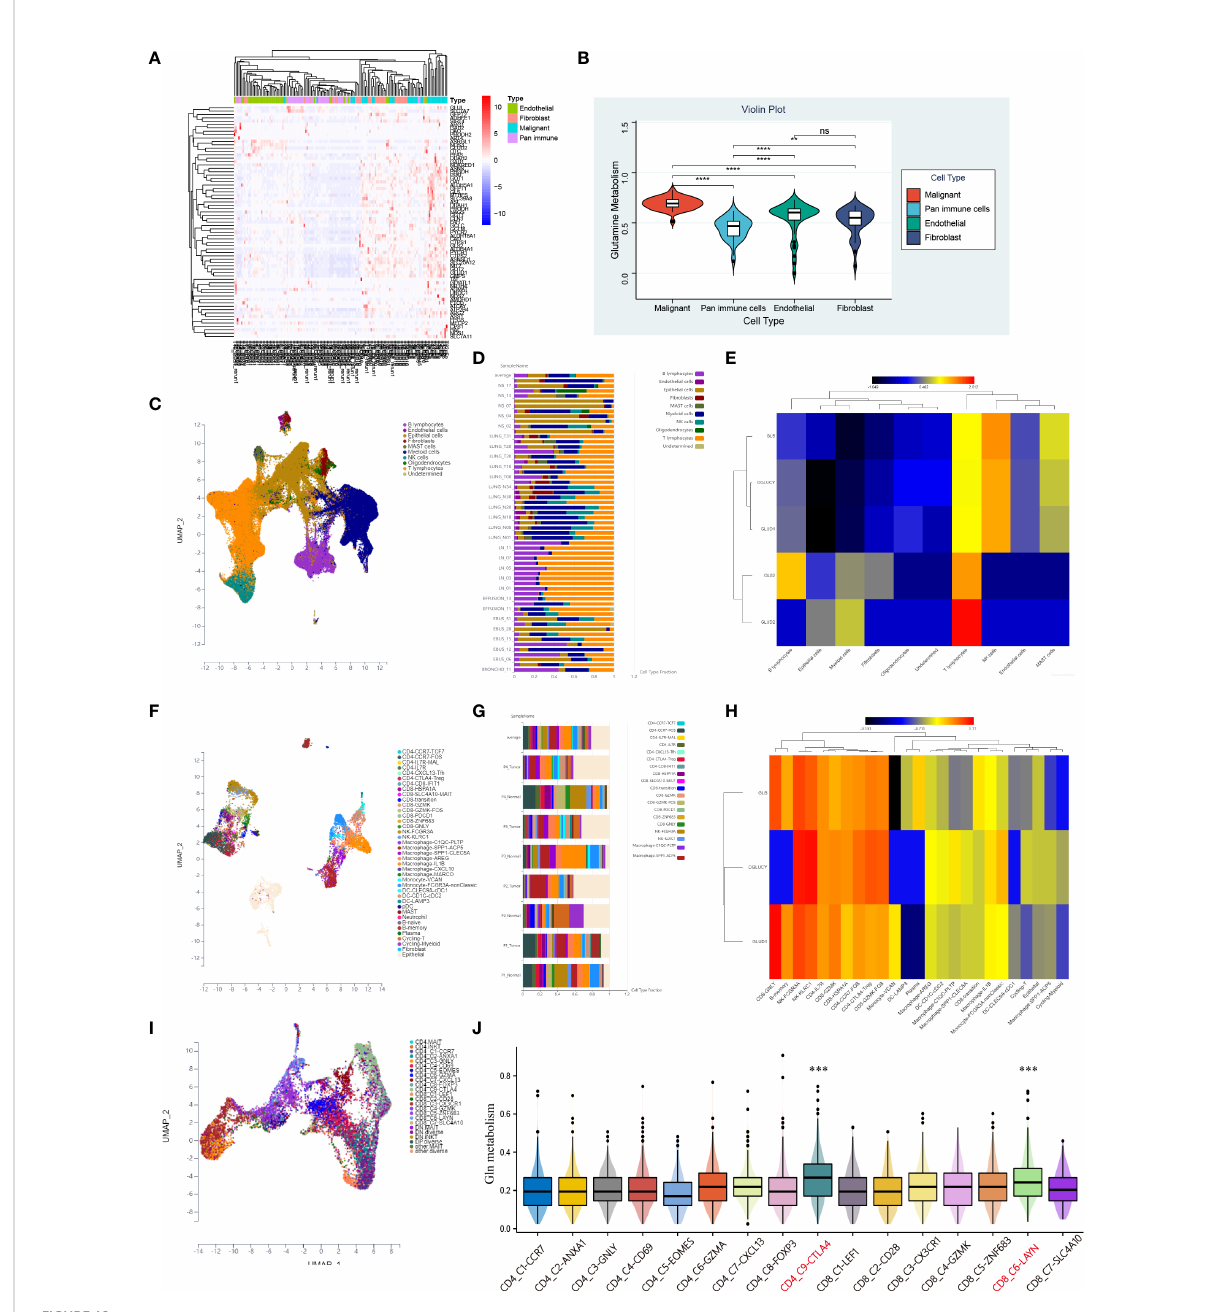
FIGURE 12 Characteristic of Gln metabolism in TME. (A) Expression of identi fi ed Gln metabolism regulators in malignant cells, endothelial cells, fi broblasts and pan-immune cells. (B) Difference of Gln metabolism levels in malignant cells, endothelial cells, fi broblasts and pan-immune cells. (C) The distribution of immune cell clusters in UMAP plot of GSE131907. (D) Cell type fraction of each sample in GSE131907. (E) Expression of key Gln metabolism regulators in immune cells of GSE131907. (F) The distribution of immune cell clusters in UMAP plot of GSE117570. (G) Cell type fraction of each sample in GSE117570. (H) Expression of key Gln metabolism regulators in immune cells of GSE117570. (I) The distribution of T cell clusters in UMAP plot. (J) Level of Gln metabolism in 16 distinct T cells. “ ** ” means that p < 0.01; " “ *** ” means that p < 0.001; **** ” means that p < 0.0001; no signi fi